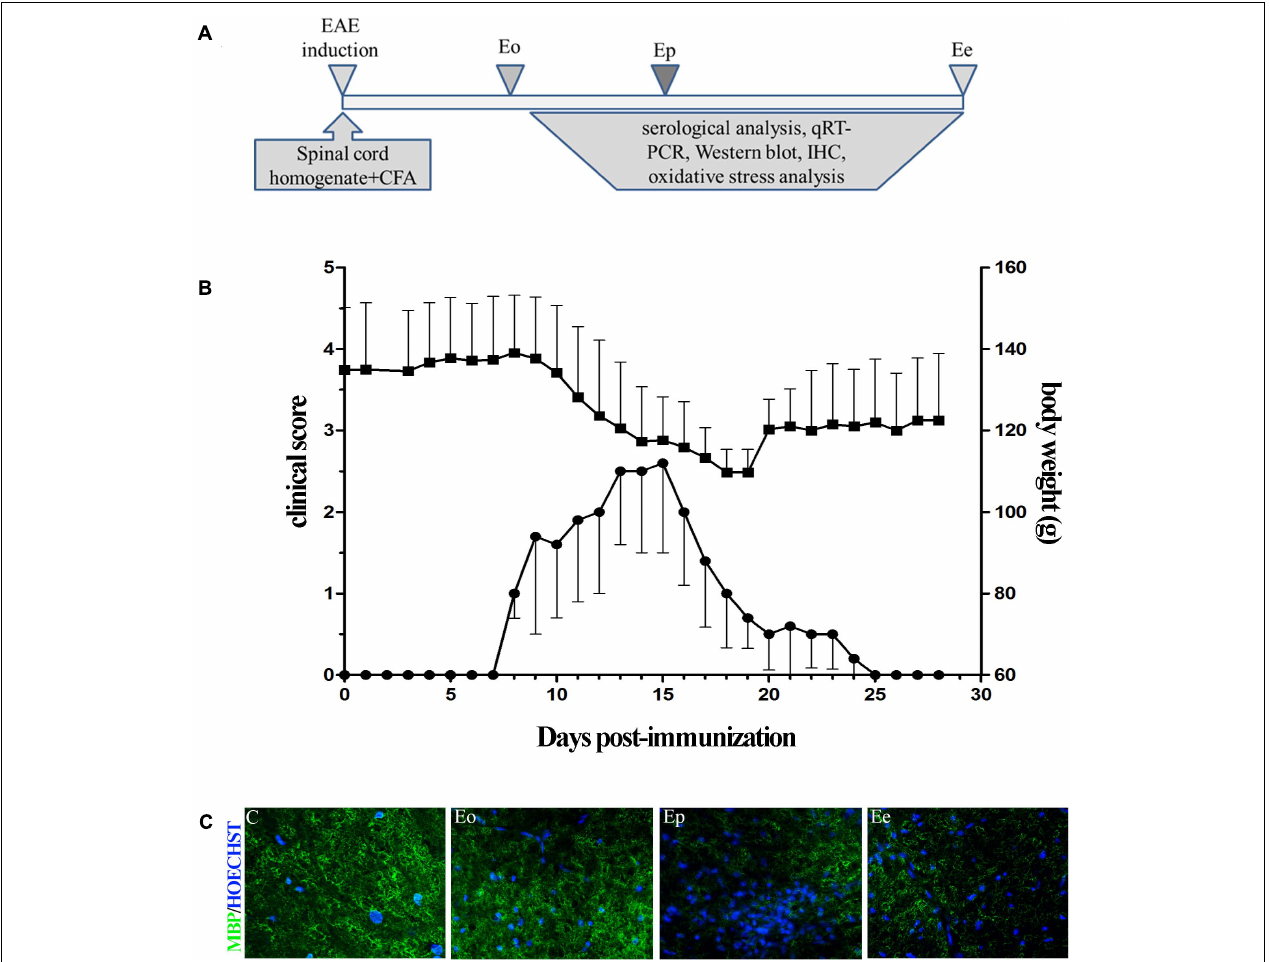
FIGURE 1 | (A) Timeline of the experimental design. Rats were immunized with the homogenate of the spinal cord and CFA. The rats were sacrificed at the onset of the first symptom (Eo), peak of disease (Ep), and end of symptoms (Ee). (B) Time course of experimental autoimmune encephalomyelitis (EAE) symptoms and variation in the weight of the animals. Data have been expressed as mean ± SEM of daily measurements of each animal. (C) Inflammation was observed using Hoechst stain (blue), while demyelination was detected using the MBP antibody (green